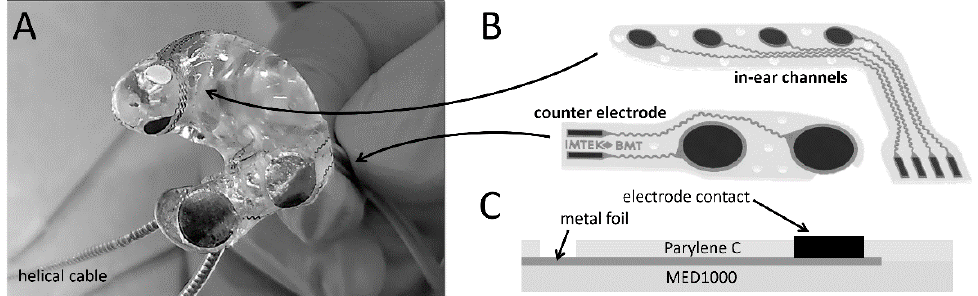
Figure 1. ( A ) Image of the fully assembled Ear-EEG electrode with four electrodes in the ear canal (3 mm diameter) and two large counter electrodes with a 6mm diameter. The in-ear electrode arrays are personalized laser design files with adjusted electrode spacing for an equidistant electrode spacing in the auditory channel ( B ). The two electrode mats have the same layering ( C ); a medical grade silicone laminated with a structured metal foil, encapsulated with 10 µm Parylene C.